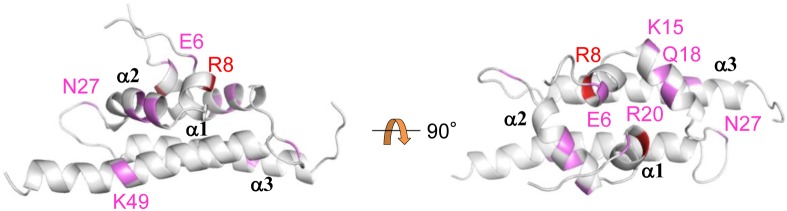
Distribution of the seven amino acid residues important for homo-oligomerization of Pmr_nt61.The seven residues are highlighted in the structural model of the Pmr_nt61 dimer. R8 is shown in red because its effect on the homo-oligomerization of Pmr_nt61 was the greatest among the seven residues. The other residues are shown in pink. “α1”, “α2”, and “α3” are the names of helices from the N-terminus of a Pmr_nt61 protomer.